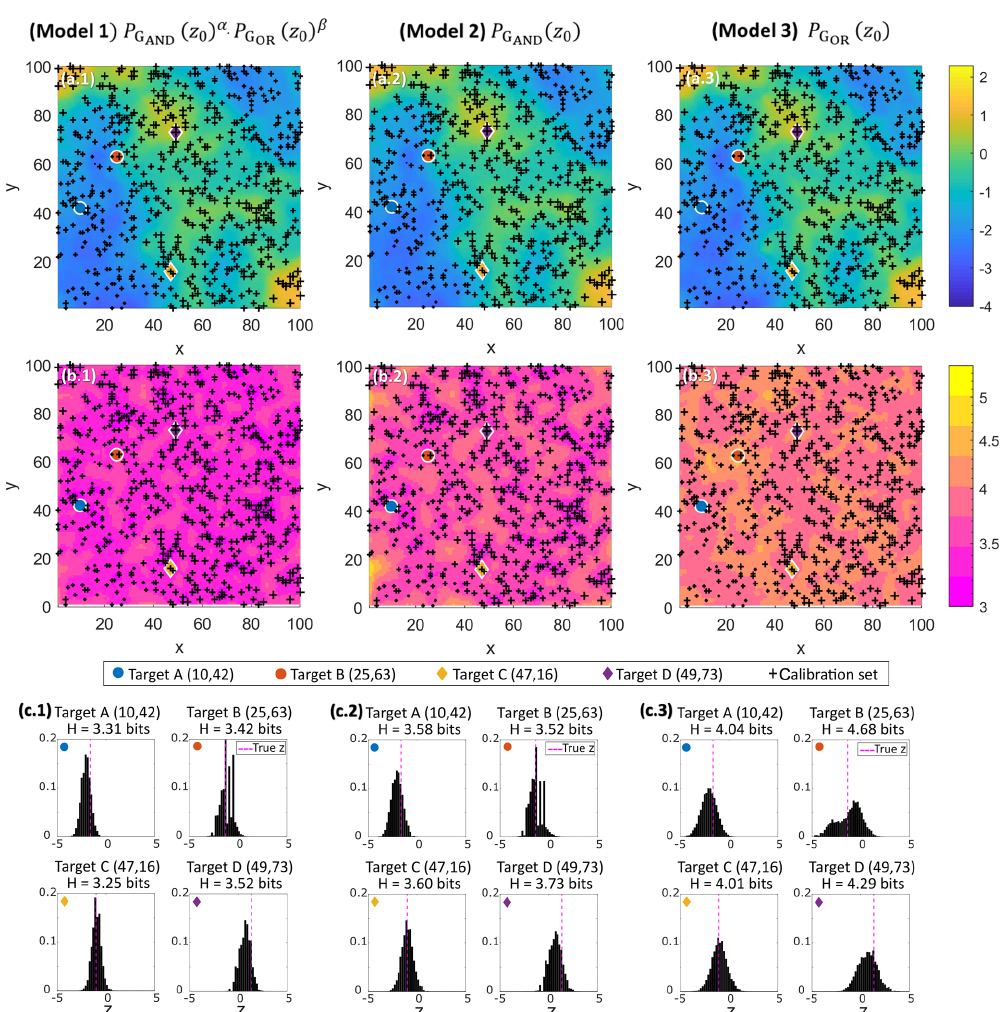
Figure 7. LR1-600 results showing the (a) E-type estimate of z , (b) entropy map (bit), and (c) z PMF prediction for selected points. The first, second, and third columns of the panel refer to the results of model 1 (AND/OR), model 2 (AND), and model 3 (OR),